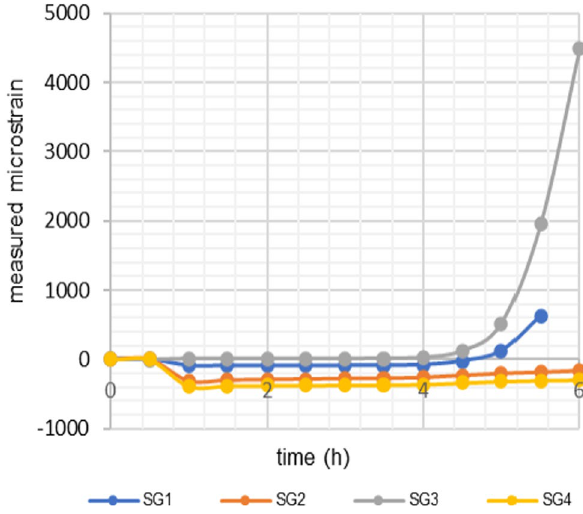
0 b Initial breakage c Break-